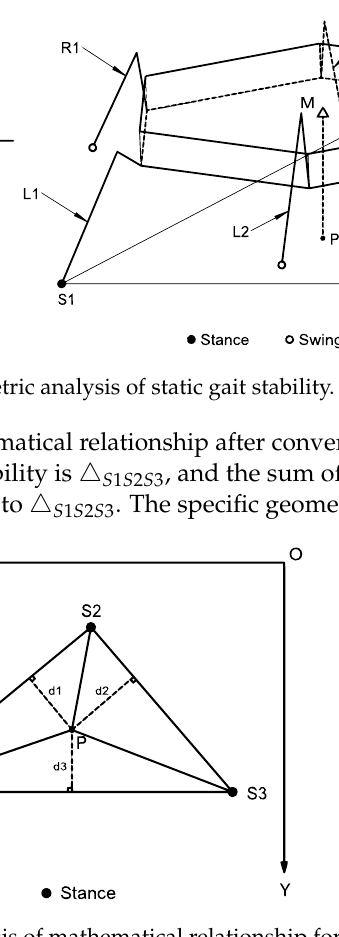
Figure 12. Analysis of mathematical relationship for static gait stability. The coordinates of S 1, S 2, S 3, and point P of the robot can be known by moving in the XOY plane, and the coordinates are set as S 1( x 1 , y 1 ), S 2( x 2 , y 2 ), S 3( x 3 , y 3 ), and P ( x P , y P ), respectively, so that the areas of the four triangles can be